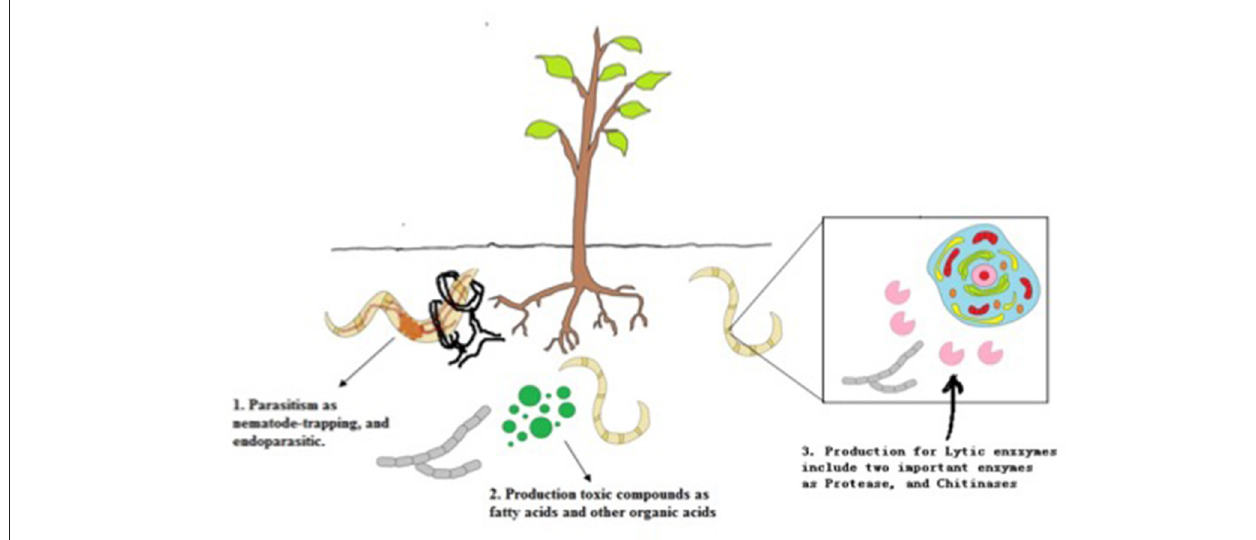
FIGURE 2 | The types of mechanisms used by NF to infect nematodes.